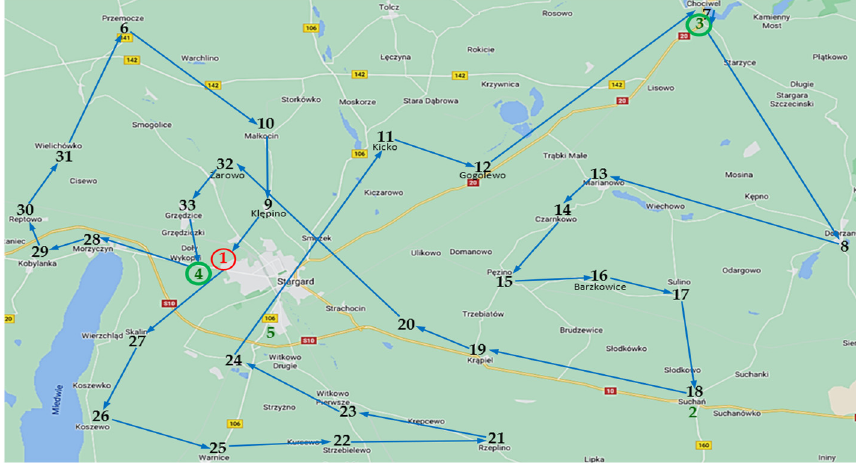
Figure 6. The visualization of the found solution for the first